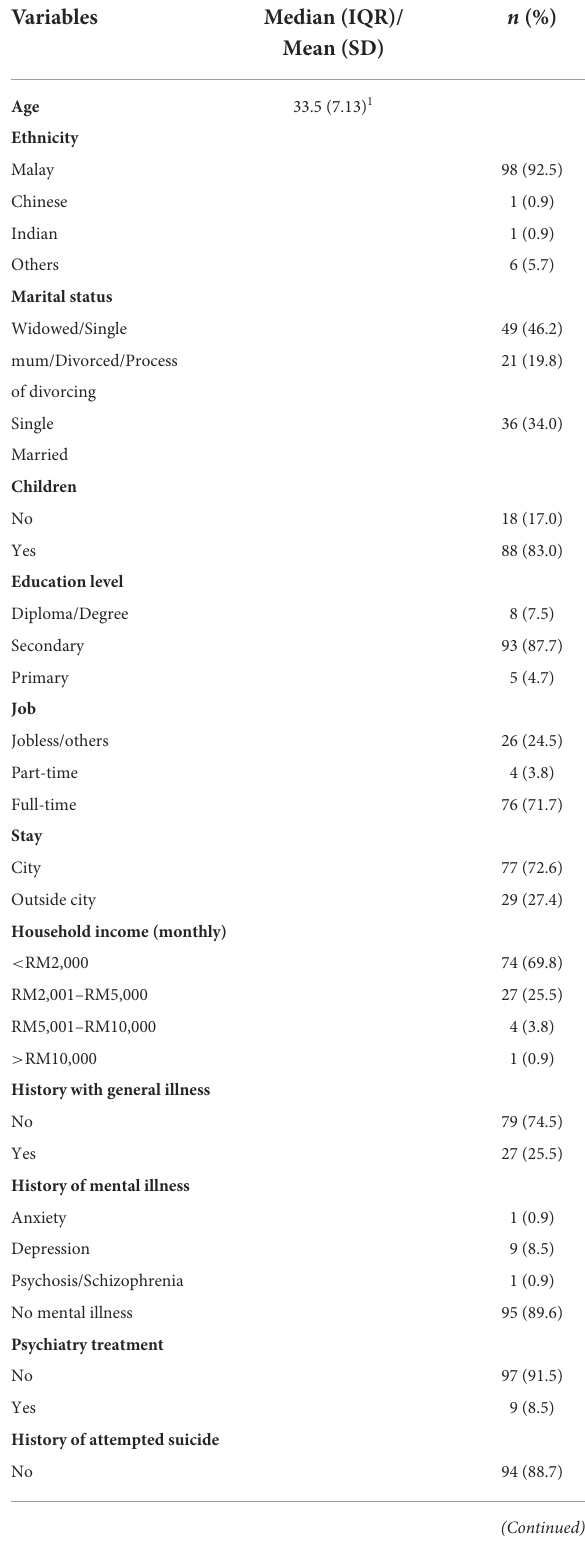
TABLE 1 Sociodemographic characteristics, health profiles, childhood trauma, intimate partner violence, and types of substance used variables among women with substance use in a rehabilitation center ( n =